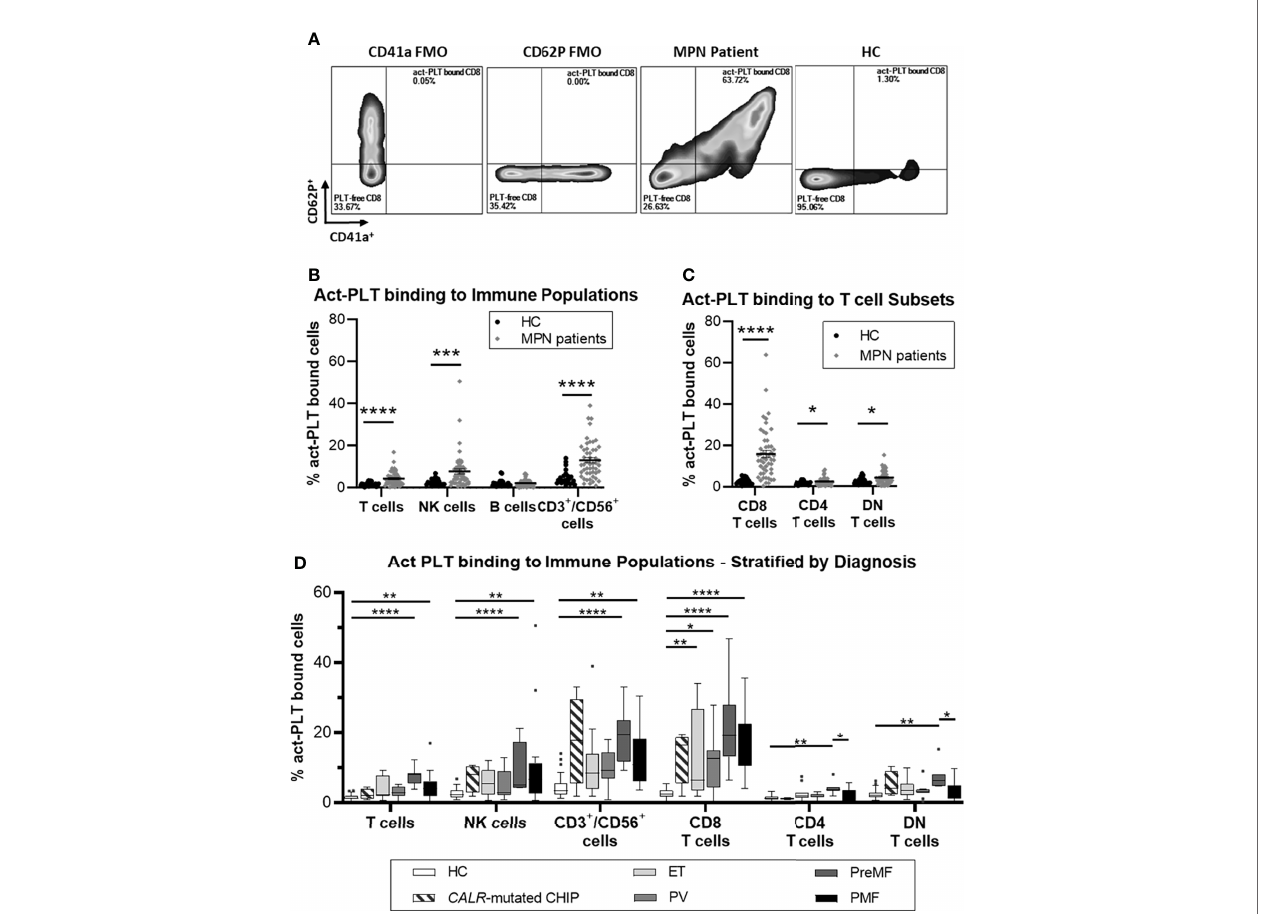
FIGURE 1 | MPN patients have increased frequencies of circulating act-PLT bound cells compared to HC. Cryopreserved PBMCs from 50 patients with chronic myeloproliferative neoplasms (MPN) and 24 age-matched healthy controls (HC) were analyzed using fl ow cytometry (Panel I, Supplemental Table 1 ). Activated- Platelet (act-PLT) binding populations were identi fi ed by their concurrent expression of PLT markers (CD41a + /CD62P + ) and immune speci fi c markers, i.e. , CD3 + / CD56 - (T cells), CD3 - /CD19 + (B cells), CD3 - /CD56 + (NK cells), CD3 + /CD56 + (CD3 + /CD56 + cells) CD3 + /CD8 + (CD8 T cells), CD3 + /CD4 + (CD4 T cells) and CD3 + / CD8 - /CD4 - (DNT cells). (A) Representativeplots, comparing the frequency of act-PLT bound CD8 T cells in MPN and HC. CD41a andCD62P fl uorescence minus one (FMO)were used as control.(See Supplemental Figure 1 for detailed gatingstrategy). Frequencies of act-PLTbinding to (B) the main lymphocytic populationsand (C) the T cellsubsets were compared in HC ( (cid:129) ) and MPN patients ( ♦ ). (D) These frequencies were also compared across the different diagnoses within the patient population – essential thrombocythemia (ET; n = 11),Polycythemia Vera (PV; n = 11), Pre-myelo fi brosis (PreMF; n = 7),and primarymyelo fi brosis (PMF; n = 17) - andincludingHC and asymptomaticindividualscarryinga low CALR -mutant allelic burden ( CALR- mutatedCHIP; n = 4).All frequencies are shown as percentage ofparent population. The horizontal lines and error whiskersrepresent the mean ± standard deviation ofthe mean, whereas boxplots follow the Tukey method.Unpaired T test was used to compare MPN patientand HC, whereas Kruskal-wallis test was used to compare the different mutation groups with n ≥ 6. Differences were considered signi fi cant when p < 0.05, as indicatedwith asterisks(*p < 0.05, **p< 0.01, ***p< 0.001, and ****p <